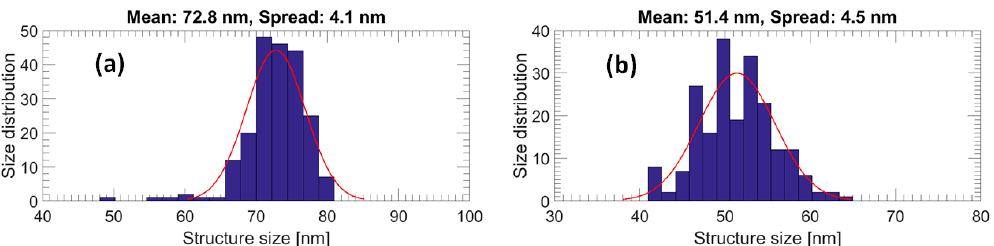
Figure 5. Diameter distribution measured from top-view SEM images of Si nanopillars on Si stamp exposed by different doses: ( a ) 40 µC/cm 2 ; ( b ) 28 µC/cm 2 .